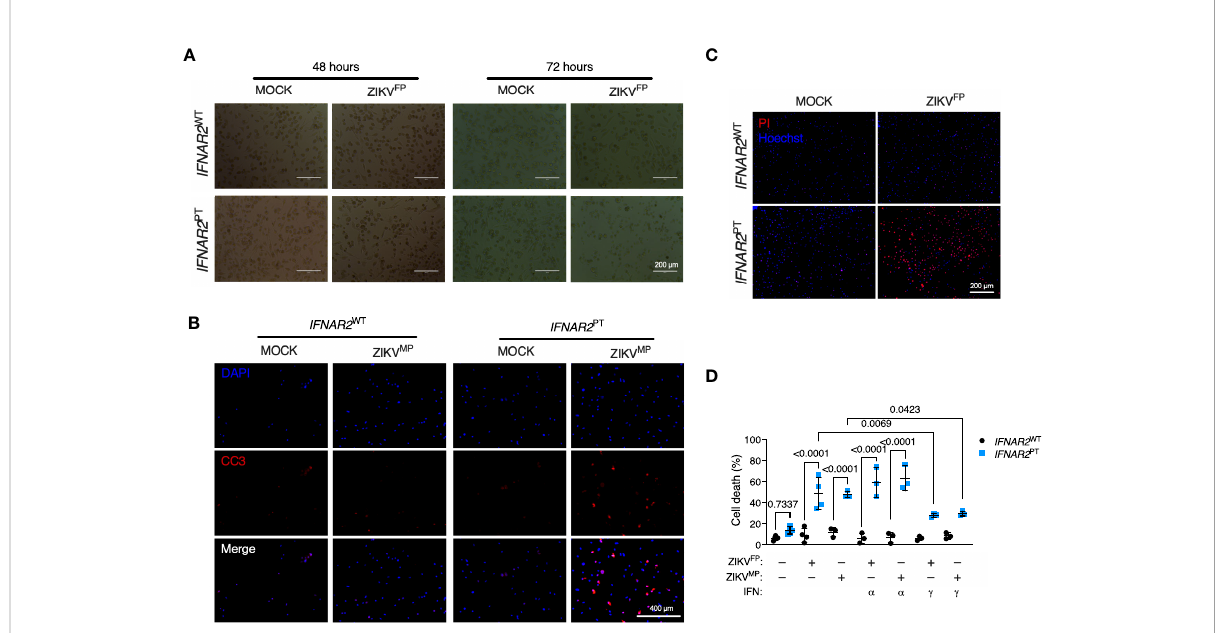
FIGURE 5 IFNAR2 -de fi cient iPS-macrophages are vulnerable to ZIKV cytopathic effects. (A) Progressive cytopathicity in IFNAR2 PT (clone 6) but not IFNAR2 WT (WT2) iPS-M f following infection with ZIKV FP MOI = 1.0, showing morphological features of cell shrinkage, membrane blebbing and cell fragmentation. Scale bar, 200 m m. (B) Immuno fl uorescence analysis of cleaved caspase 3 (CC3) at 48 h.p.i. ZIKV MP MOI = 1.0. Representative images of two independent experiments. Scale bar, 400 m m. (C) Immuno fl uorescence analysis of cell viability showing representative images of cell death at 72 h.p.i. ZIKV FP MOI = 1.0 in IFNAR2 PT (clone 11) but not IFNAR2 WT (WT2) iPS-M f , representative of n = 4 independent experiments. Scale bar, 200 m m. (D) CellPro fi ler quanti fi cation of cell viability assay in IFNAR2 PT (clone 11) and IFNAR2 WT (WT1 and WT2) iPS-M f with or without recombinant IFN a 2b or IFN g (1000 IU/mL) pretreatment. 72 h.p.i. ZIKV FP MOI = 1.0 (n = 4 independent experiments) or ZIKV MP MOI = 1.0 (n = 3 independent experiments). Mean ± SD, ANOVA with Sidak ’ s test for multiple